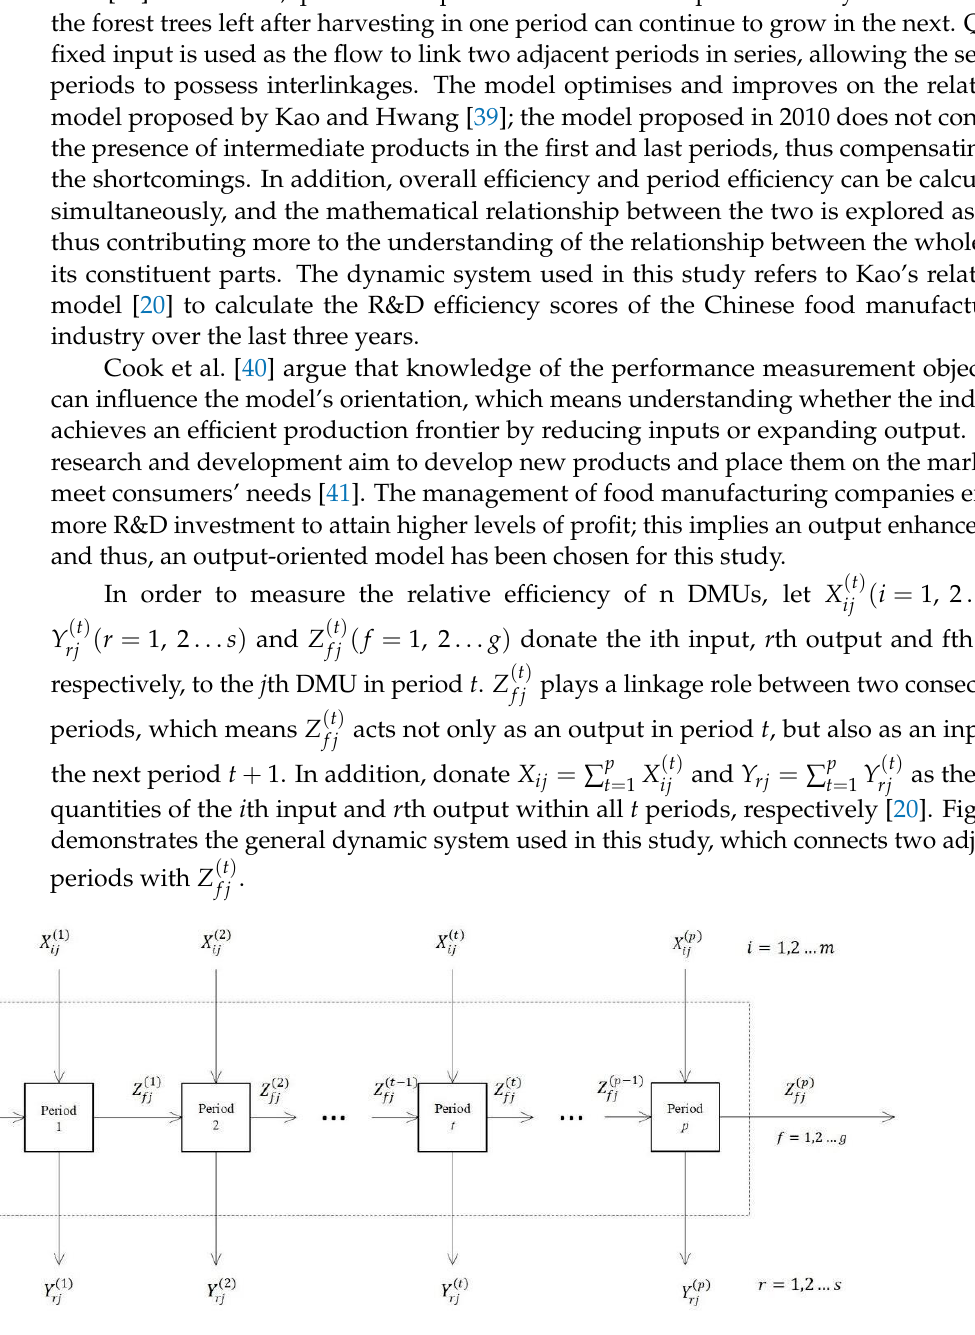
Figure 1. A general framework of the dynamic system with carry-overs. Adapted from